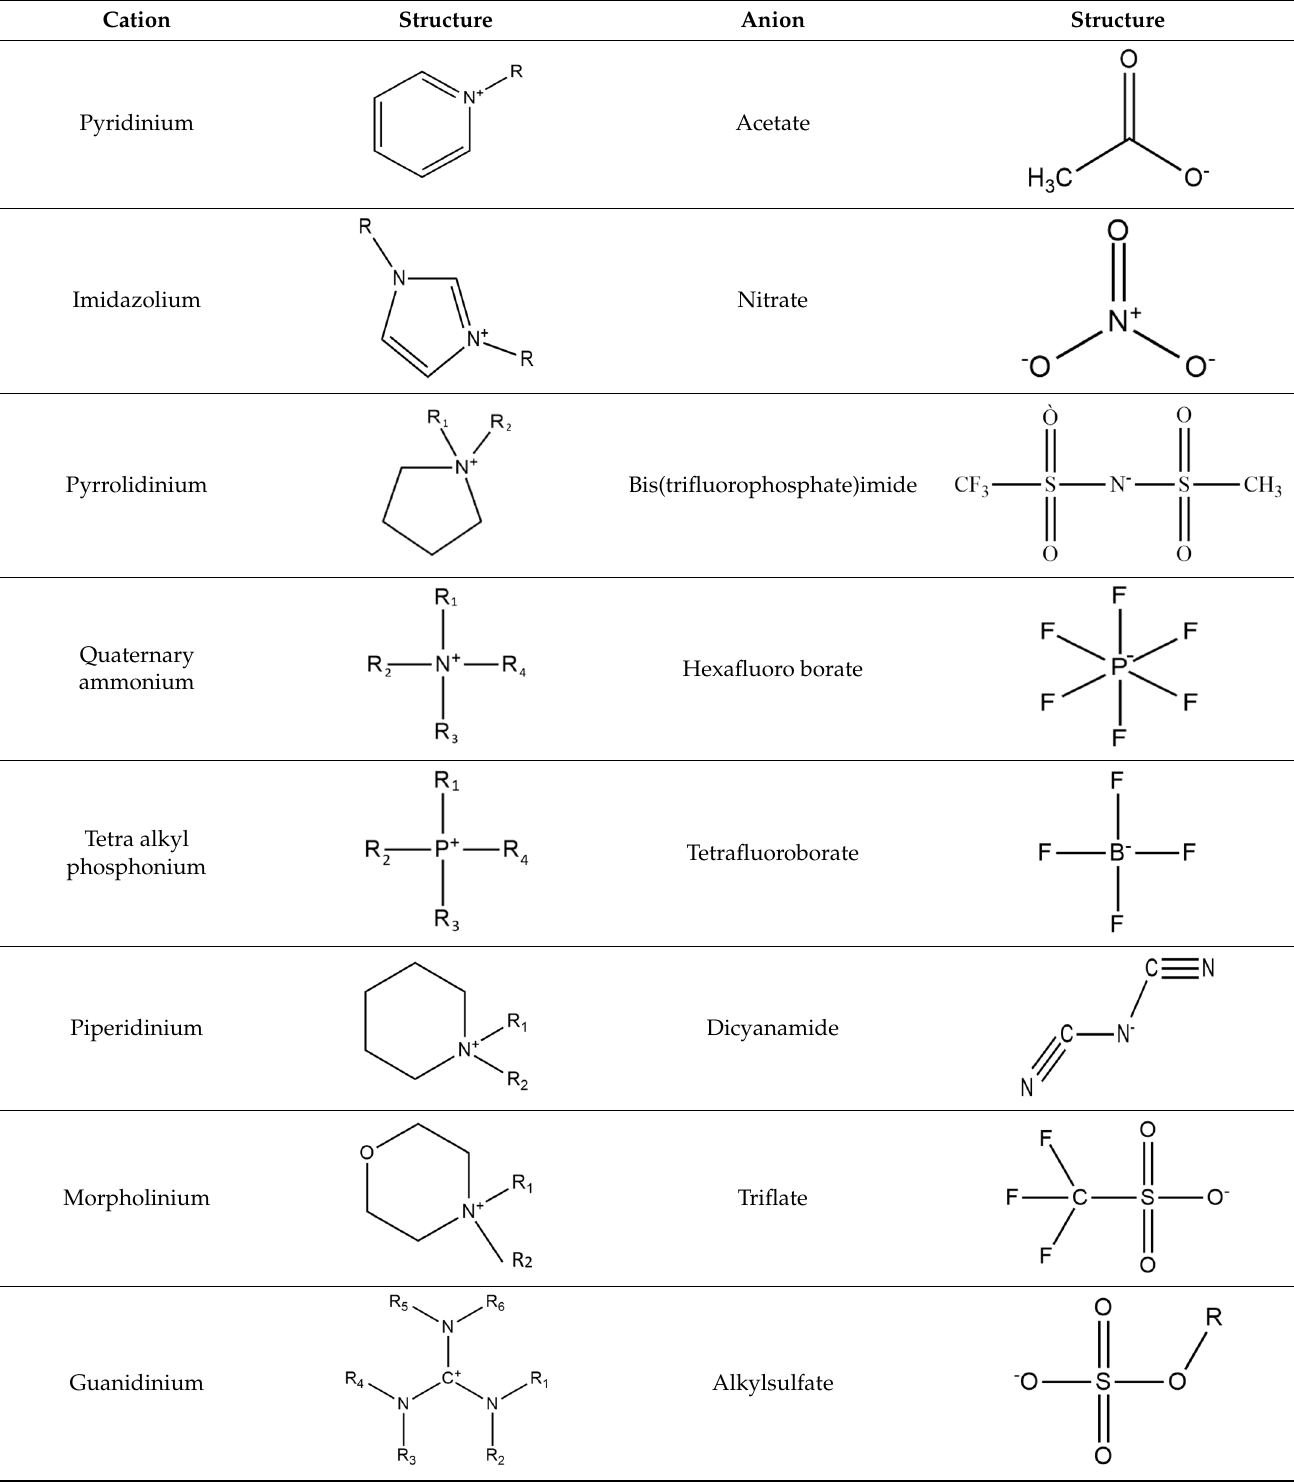
Figure 2. Comparative analysis of CO 2 -ILs systems with the VLE physical behavior of CO 2 and conventional solvent systems. At moderate pressure, the conventional solvent presents a critical point, while the IL system does not present this critical point. With permission from Ref. [41]. Cop- yright 2012, American Chemical Society. Table 2. Structures of anions and cations commonly used for synthesis of ILs. Structure Anion